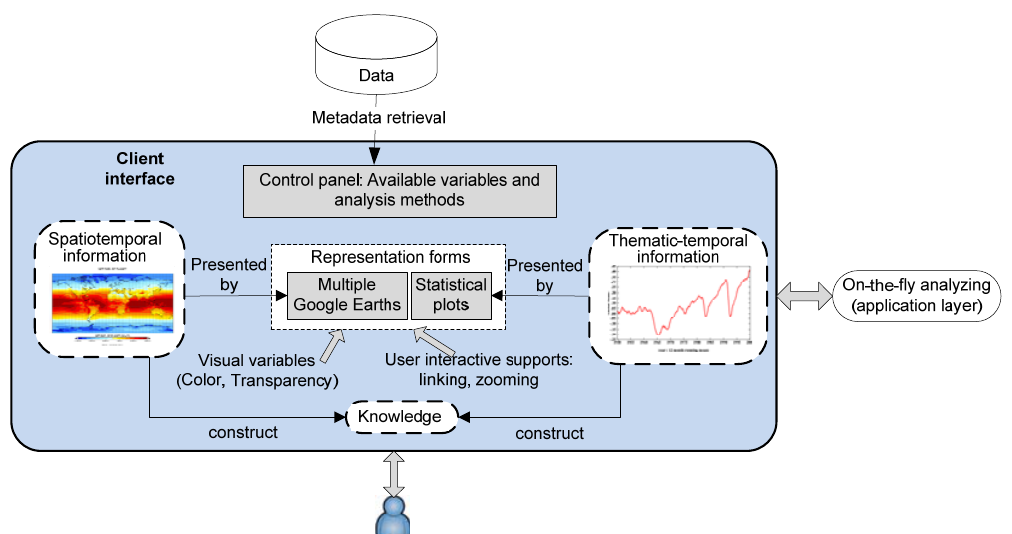
Figure 5. Mechanism of geovisual analysis on the client